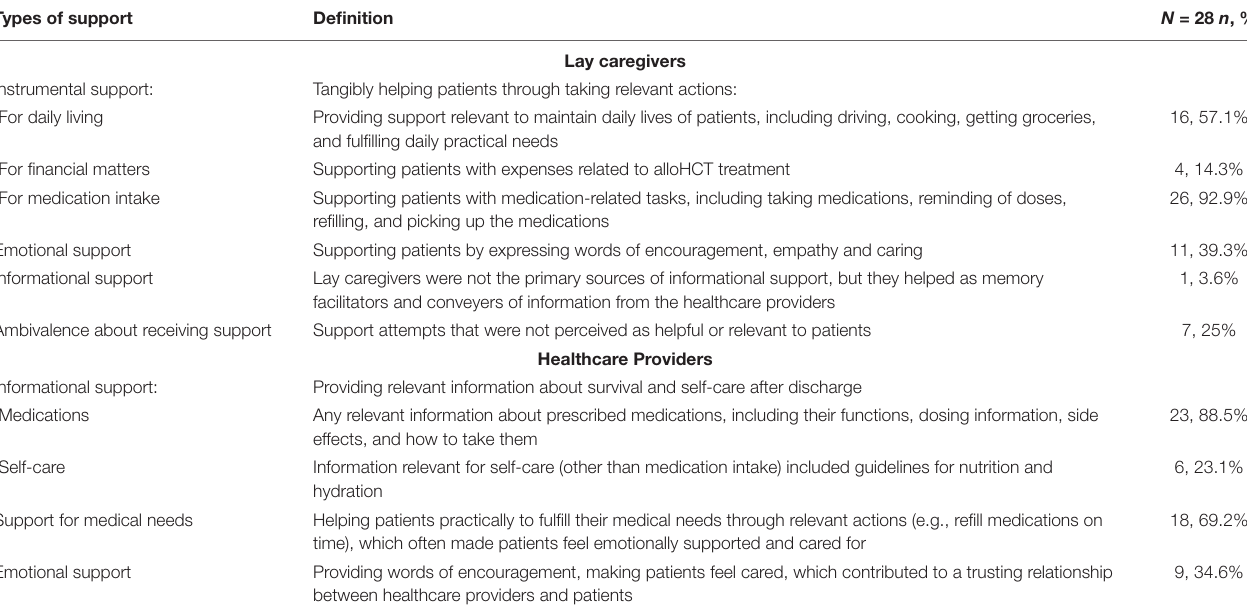
TABLE 3 | An overview of the type of support, definition and number of patients reporting it ( N = 28). Types of